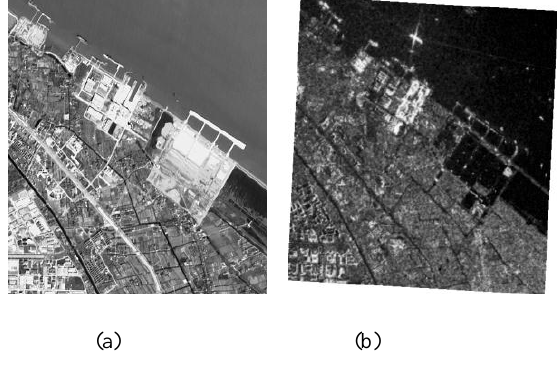
Fig.1 Registration of optical and SAR images. (a) Optical image (b) SAR image (c) The result of the proposed method. (d) The result of MIOI. (2) Fig.2 shows the optical and SAR images acquired around a port and the registration results. The optical image and SAR image are shown in Fig.2 (a) and Fig.2 (b) respectively. The registration result of the proposed method is shown in Fig.2 (c).